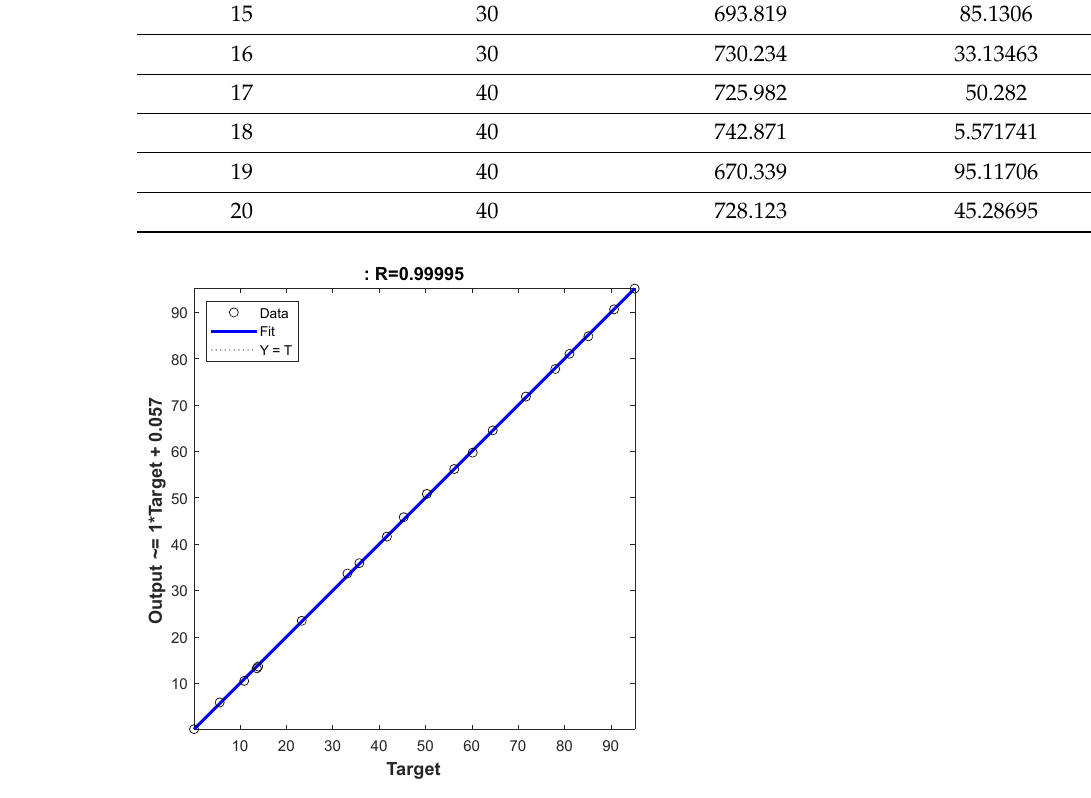
Figure 6. Regression of simulated data for ANN model. Table 4. Statistical parameters for the simulated